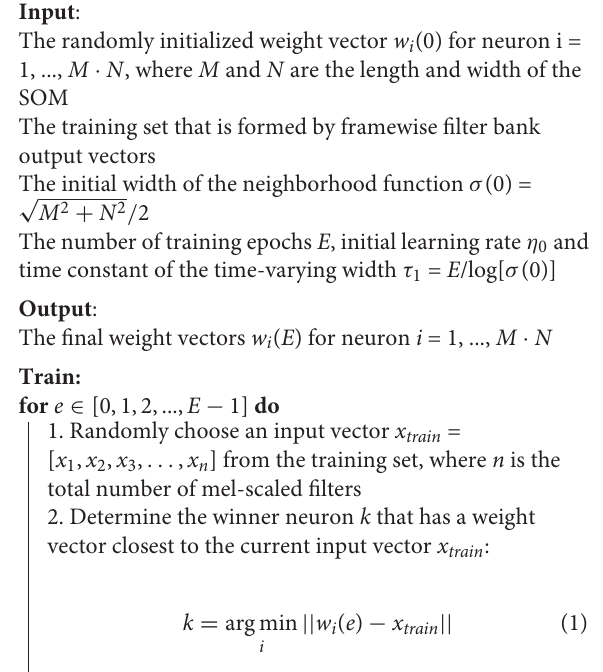
Algorithm 1: The Self-Organizing Map